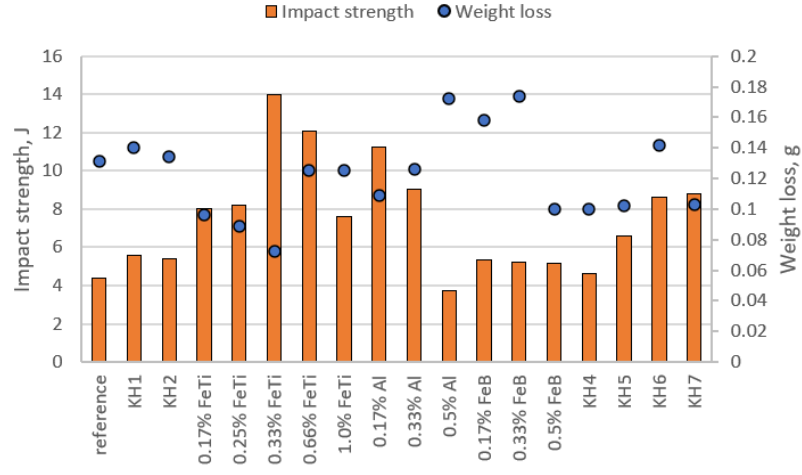
Figure 7. Results of tests of resistance to abrasive wear and impact toughness of chromium cast iron.